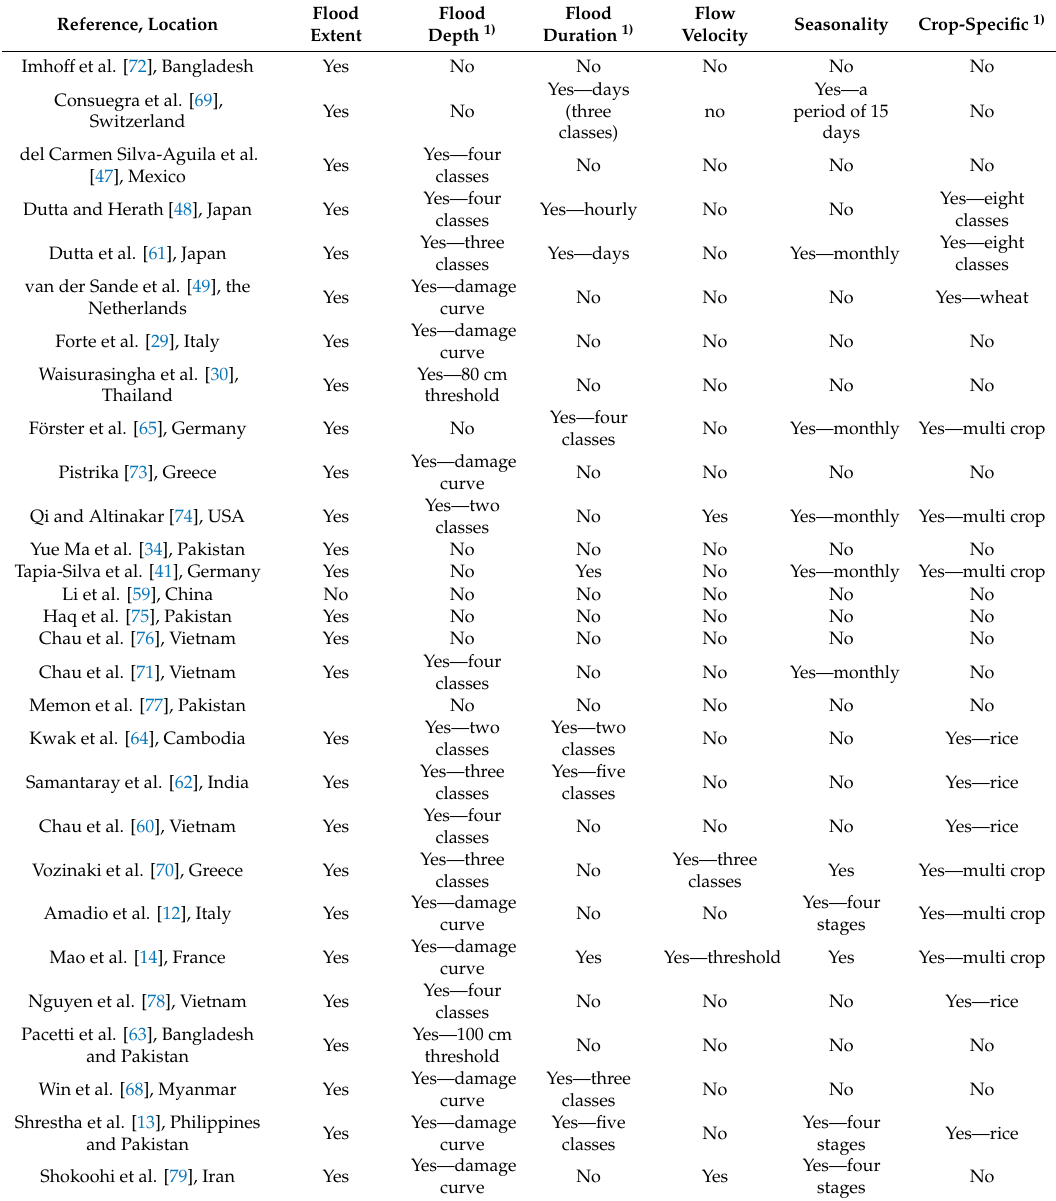
Table 1. Comparison of case studies on flood crop loss assessment regarding the considered flood intensity